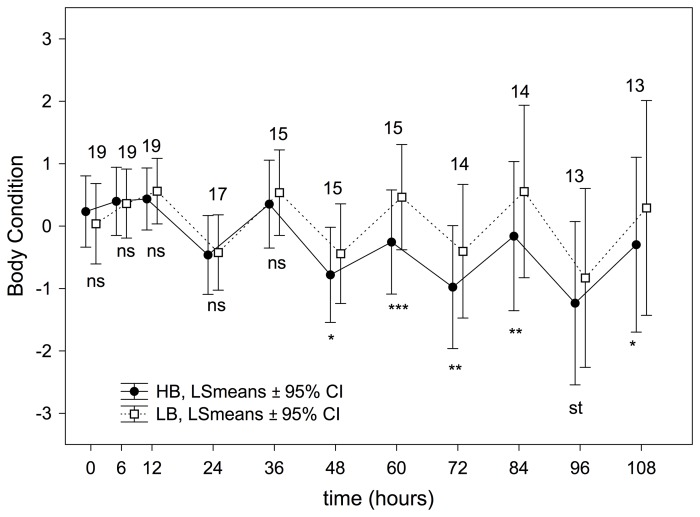
Effect of the experimental treatment on body condition calculated from RM-ANOVAs over nestling development.P-values associated with differences in each experimental session are indicated as ns: P>0.05; st: 0.1≤P≥0.05; *: P<0.05; **: P<0.001 and ***: P<0.0001. Numbers of nests (i.e. those with measurements from the four nestlings) used in each comparisons are also shown.